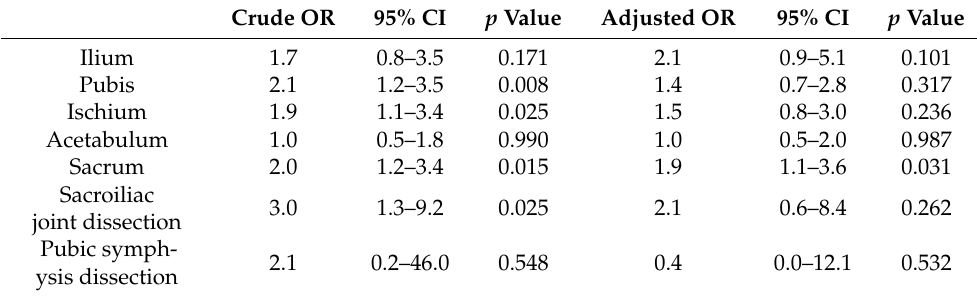
Table 4. Results of univariable and multivariable logistic regression analyses assessing the association between pelvic fracture site and requirement of blood